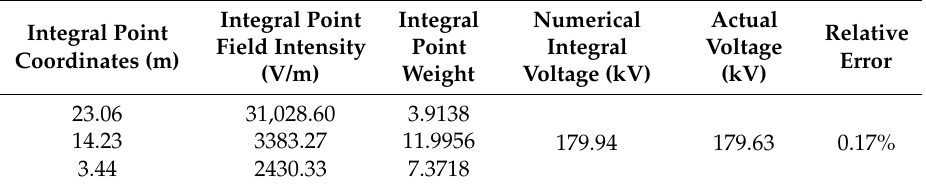
Table 2. Integration results of the Gaussian algorithm for the 220 kV transmission line.